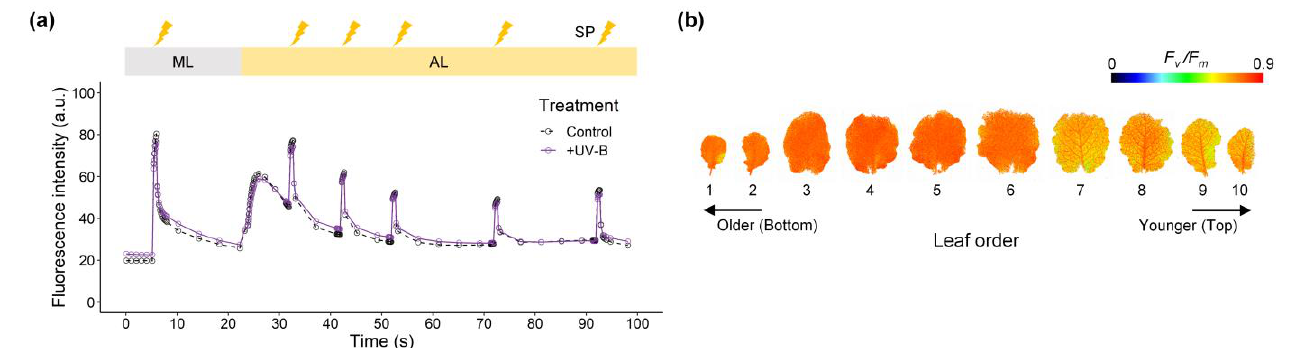
Figure A1. Light spectra of the light source. ( a ) Red, blue and white LEDs (RBW LED) at a photo- synthetically active radiation of 200 μmol m −2 s −1 ; ( b ) UV-B LED with a spectrum peak at 310 nm at a dose of 1.0 W m −2 .